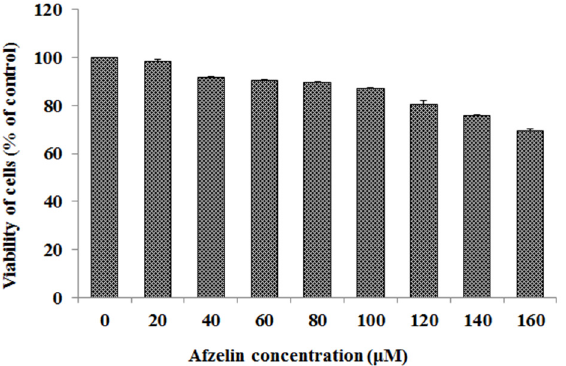
Figure 2. Viability of gastric cancer CRL-1739 cells (AGS) treated for 24 h with 20–160 µ M concentration of afzelin. Mean values ± SD are the mean of triplicate culture.